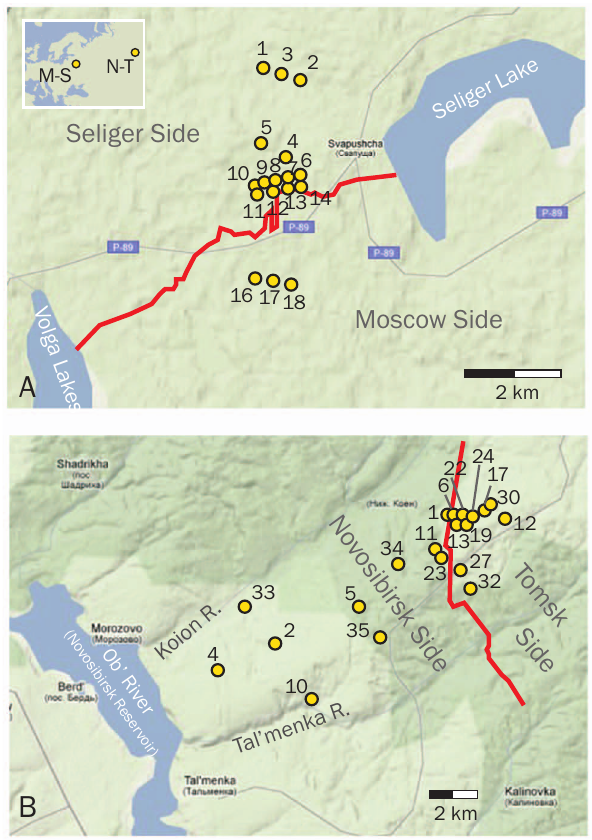
Figure 2. Maps of the Moscow-Seliger and Novosibirsk-Tomsk hybrid zones. Maps showing the sublocalities where the Moscow- Seliger clines (A) and Novosibirsk-Tomsk clines (B) were sampled. See Table S1 for details of the numbered sites. Background maps courtesy of Google Maps TM . Centers of the two chromosomal hybrid zones are shown in